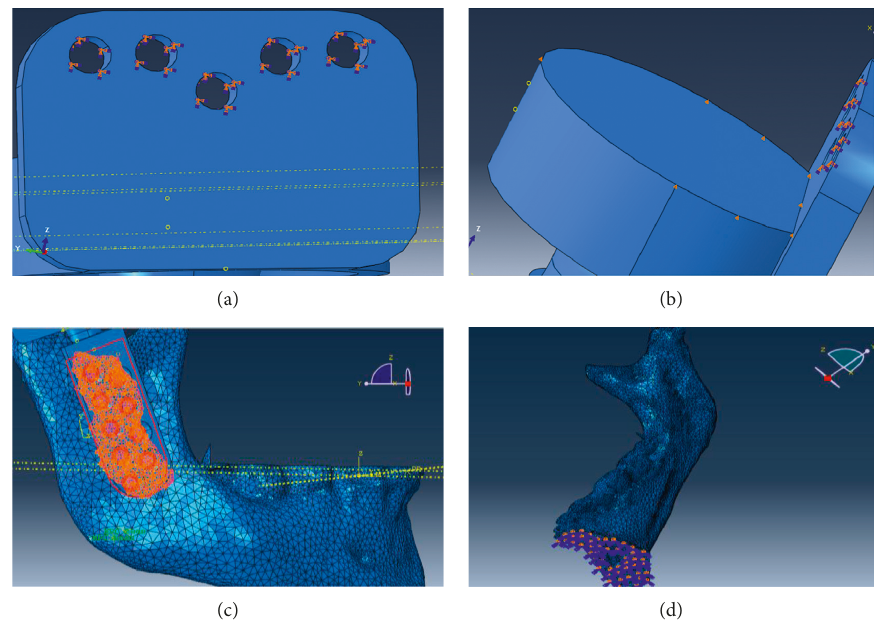
Figure 4: Boundary conditions: (a) glenoid fossa component fully constrained at the cranium bone fixation (b) and vertical constrained at the contact with glenoid fossa. (c) Mandibular component tied to the mandibular bone. (d) Symmetry conditions.